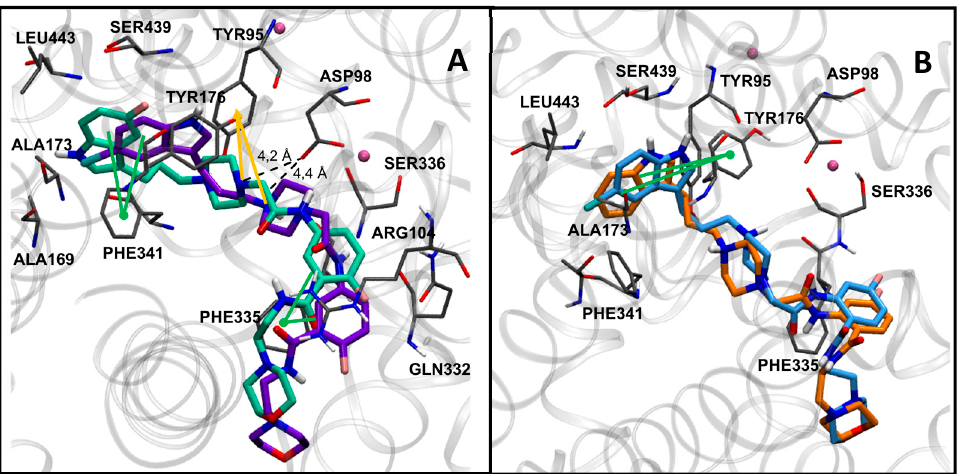
Figure 4. Docking poses in SERT obtained for compounds 13c in cyan and 13g in purple ( A ), and 13e in light blue, and 13i in orange ( B ). Nearby residues < 5 Å (grey sticks) and Na + atoms (pink spheres) are shown. Dotted lines represent ionic interactions, orange lines represent π –cation interactions, and aromatic interactions are shown with green lines.